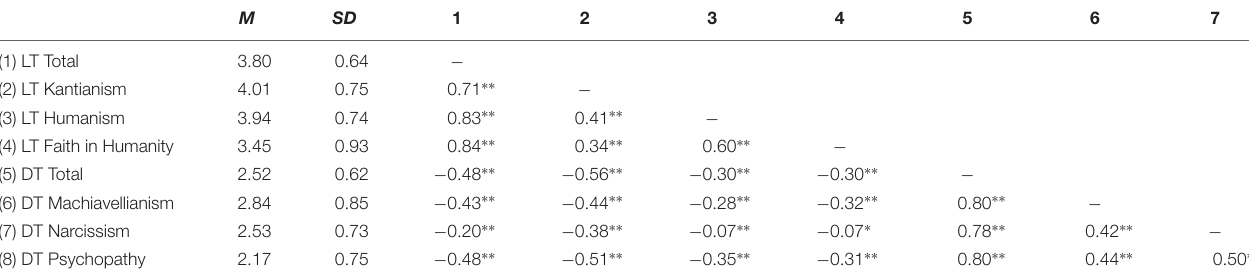
TABLE 4 | Light triad total and subscale correlations with dark triad total and subscales. M SD 1